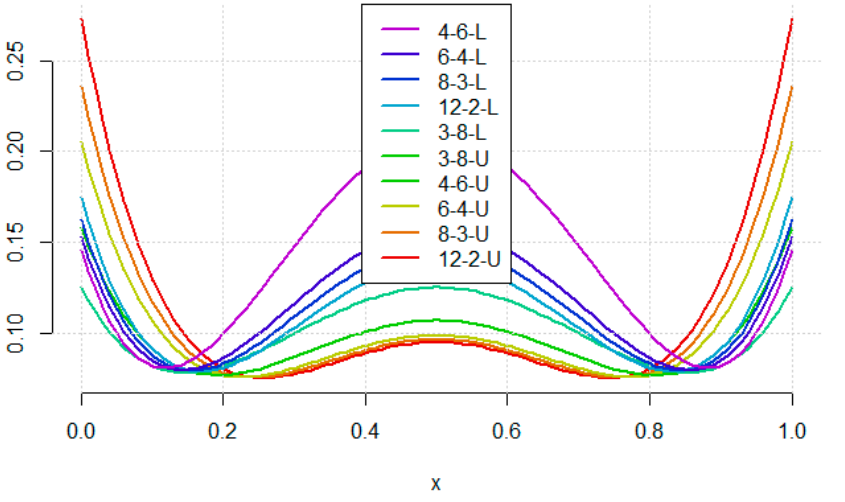
Figure 4. The prediction uncertainty shape for the quadratic model with the considered designs. For the abbreviations see text in Section 3.